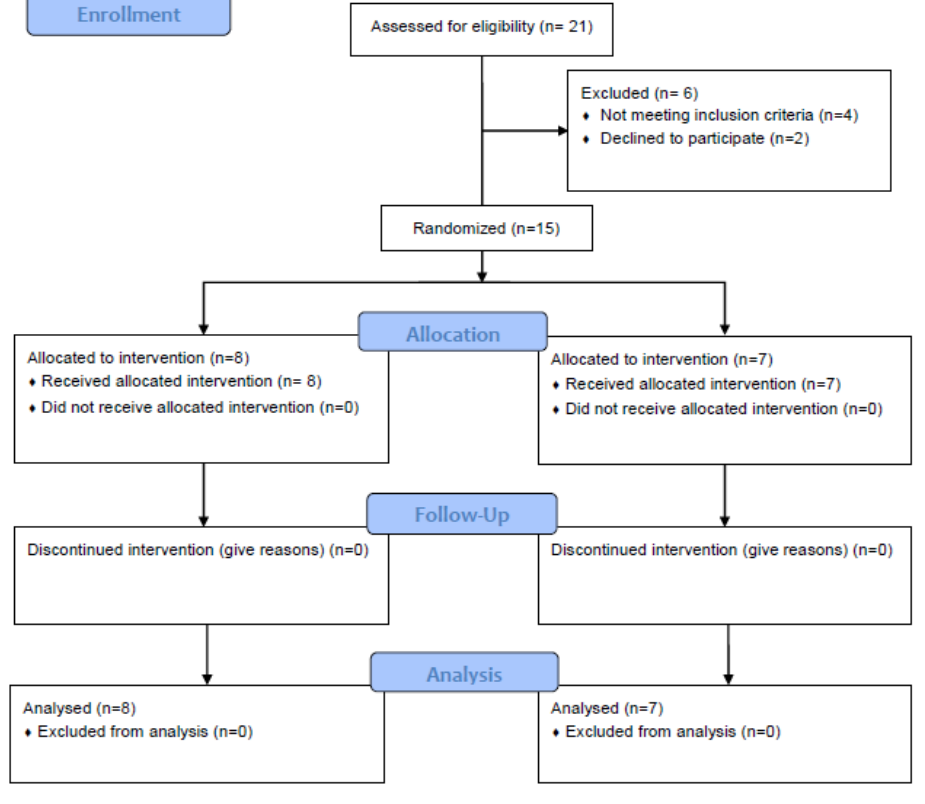
Figure 2. Study Figure 2. Study flow-chart.